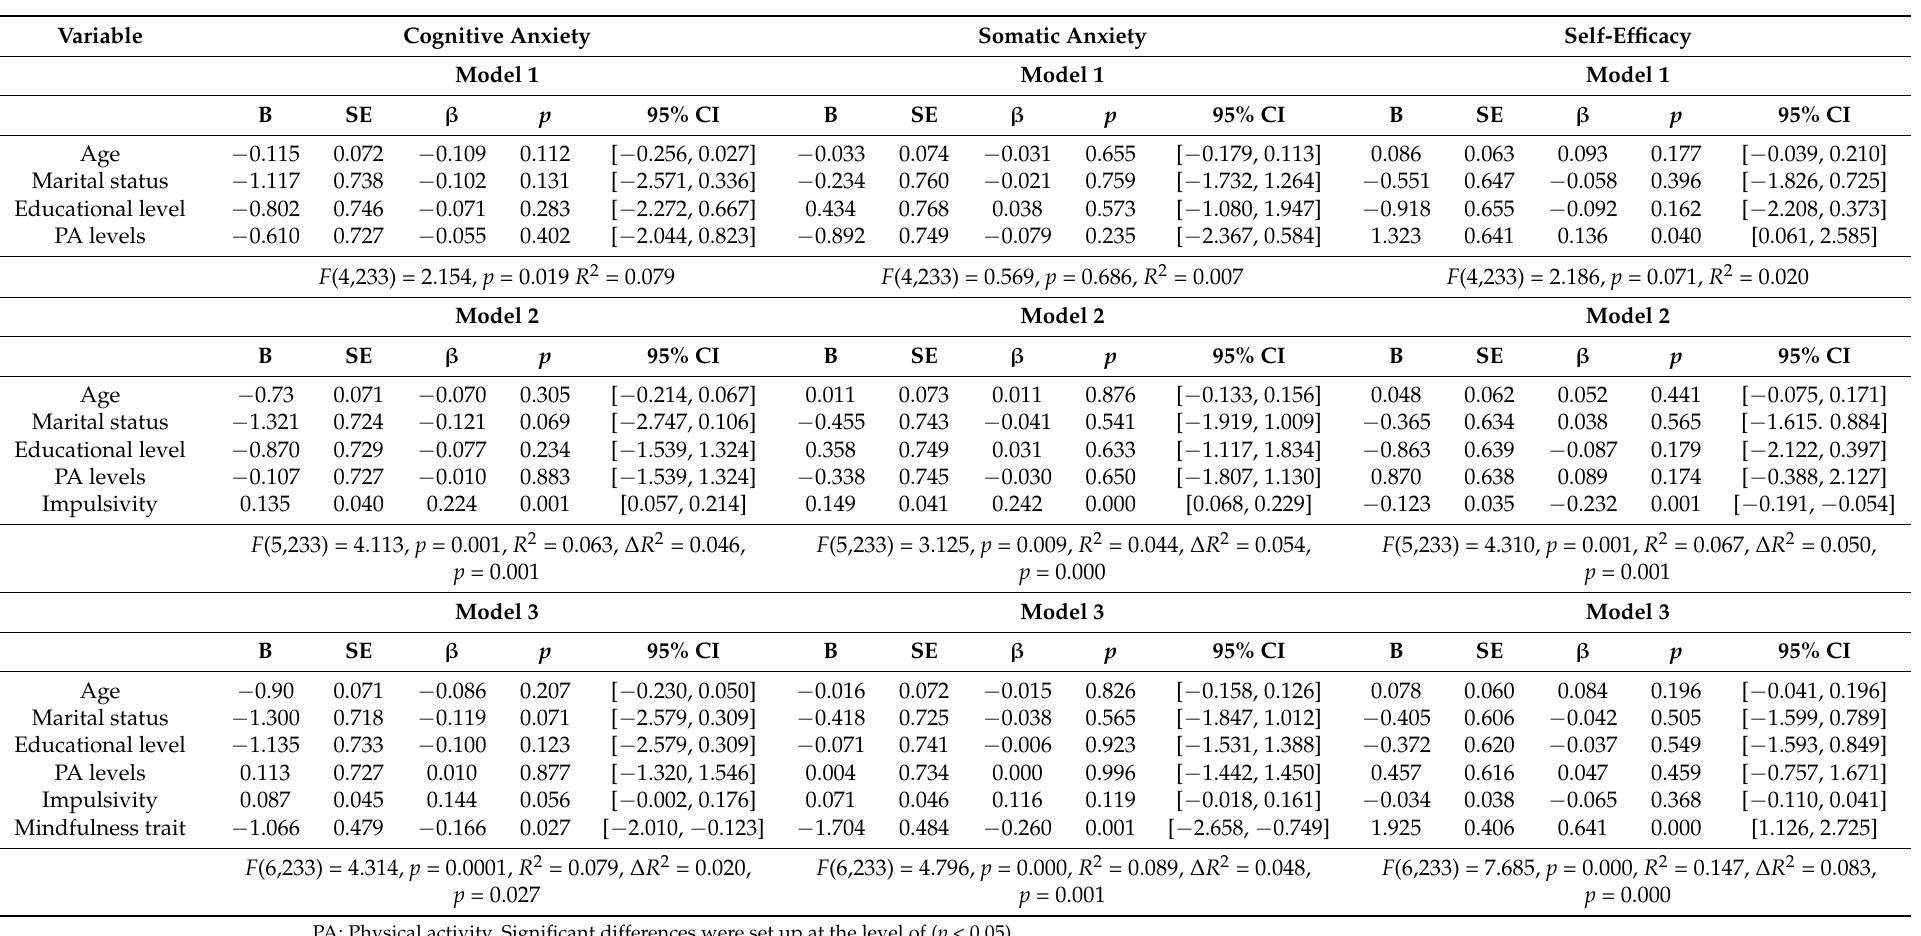
Table 4. Regression analyses of sociodemographic and physical activity, impulsivity, and mindfulness trait variables as predictors of anxiety factors.